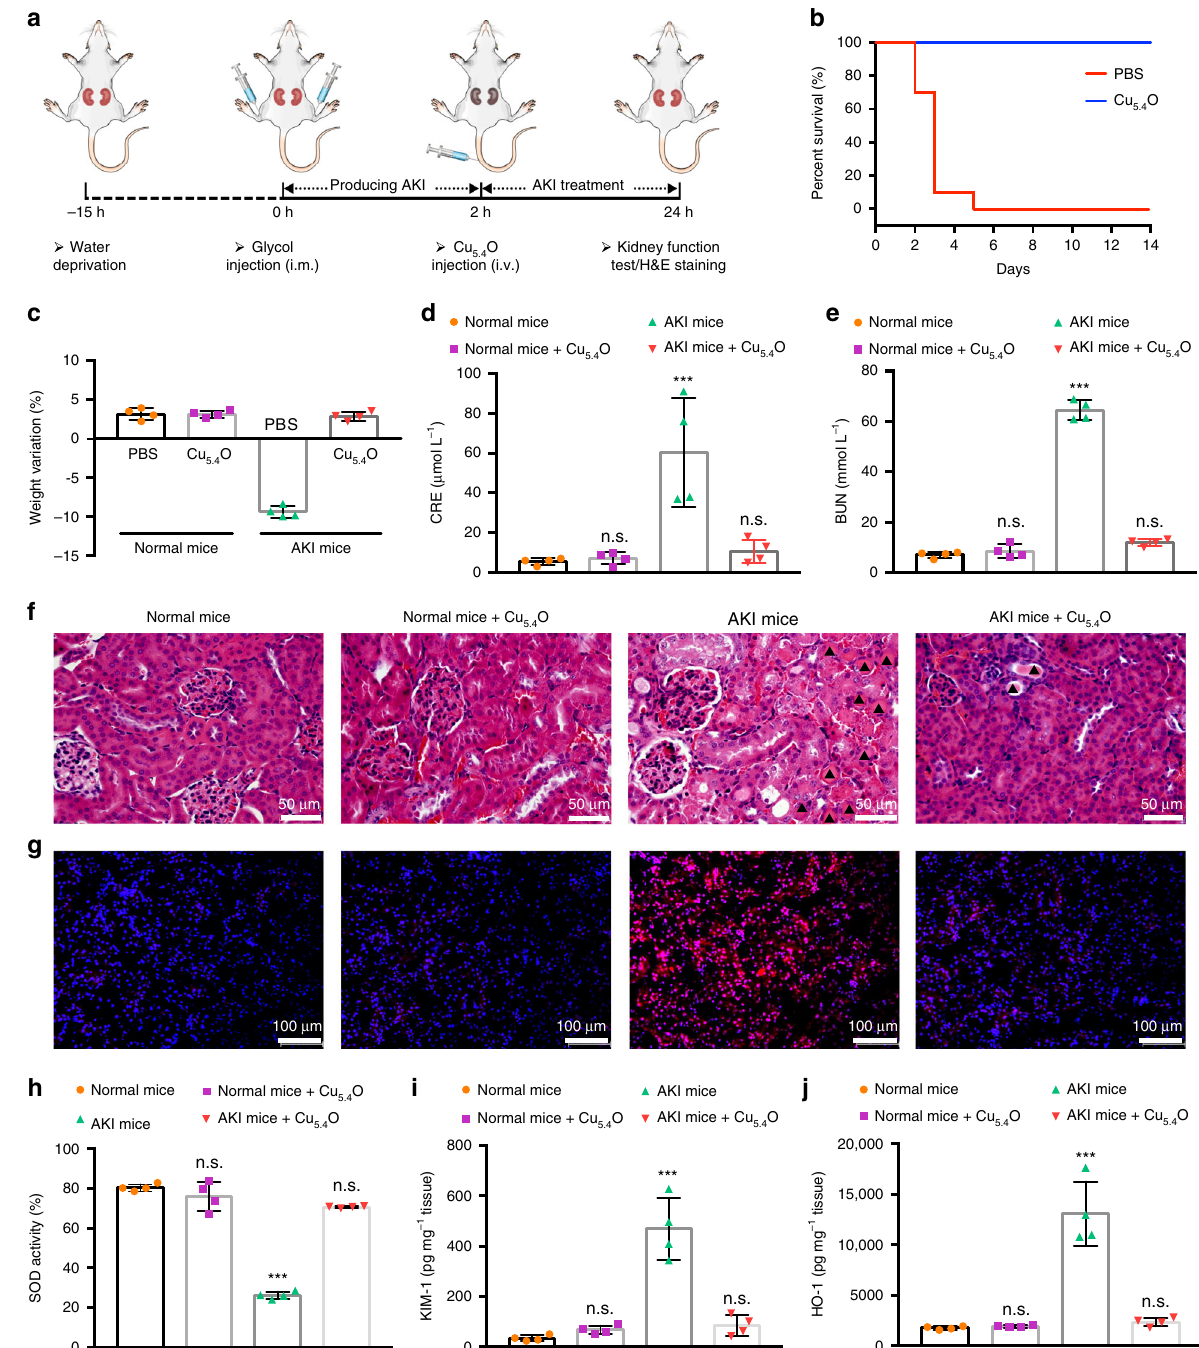
Fig. 7 Ttherapeutic ef fi ciency of Cu 5.4 O USNPs on AKI mice. a Schematic illustration of the establishment and treatment schedule of AKI mice. b Survival curves of AKI mice with different treatment. c Weight variation of AKI mice at 24 h after treatment with Cu 5.4 O USNPs. Serum levels of d CRE and e BUN in AKI mice at 24 h after different treatment. f H&E staining of kidney tissues from each group. Triangles indicate the formation of casts. g Dihydroethidium (red fl uorescence) and DAPI (blue fl uorescence) staining of kidney tissues from each group. h SOD, i KIM-1, and j HO-1 levels measured in renal tissue homogenates from each group. In c – e and h – j , data represent means ± s.d. from four independent replicates (*** P < 0.001; n.s., no signi fi cance, One-way ANOVA). Source data are provided as a Source Data fi Kyoto Encyclopedia of Genes and Genomes (KEGG) pathway the release of local or systemic in fl ammatory mediators to enrichment analysis (Fig. 9d) indicated that the glutathione (GSH) aggravate renal injury 58 – 60 . Notably, the MAPK signaling pathway (Supplementary Fig. 29) was signi fi cantly inhibited after Cu 5.4 O metabolism, MAPK signaling pathway, and TNF signaling USNPs treatment, indicating that Cu 5.4 O USNPs could alleviate pathways were highly associated with the therapeutic mechanisms renal injury via inhibiting the MAPK signaling pathway through of Cu 5.4 O USNPs. Literature has reported that ROS could activate the MAPK signaling pathway to induce renal cell apoptosis and decreasing the ROS level. In addition, it has been reported that